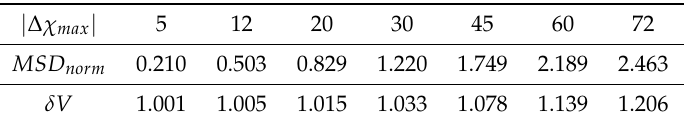
Table 2. Normalized minimum stabilization distances and velocity correction factors as functions of | ∆ χ max | for fly-over states.